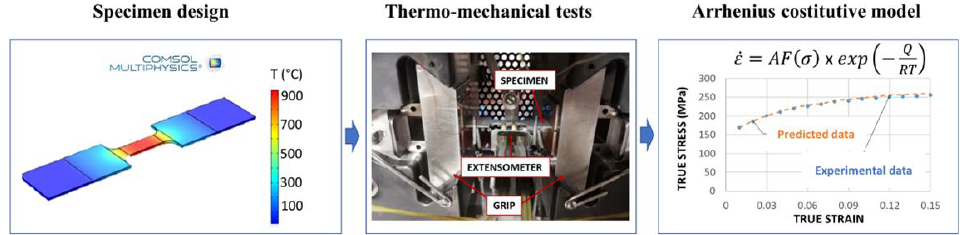
Figure 1. Scheme of adopted method (adapted from ref. [10]).